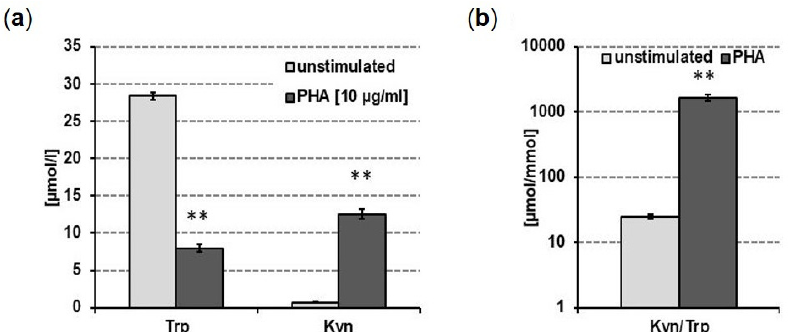
Figure 3. Comparison of ( a ) Trp, Kyn and ( b ) Kyn/Trp concentrations in the supernatants of unstimulated (light grey) and PHA-stimulated (dark grey) PBMC after 48 h of incubation. ** p < 0.005 indicates significance compared to the unstimulated cells. Results shown are mean values ± SEM of 6 independent experiments (6 donors) performed in duplicates.